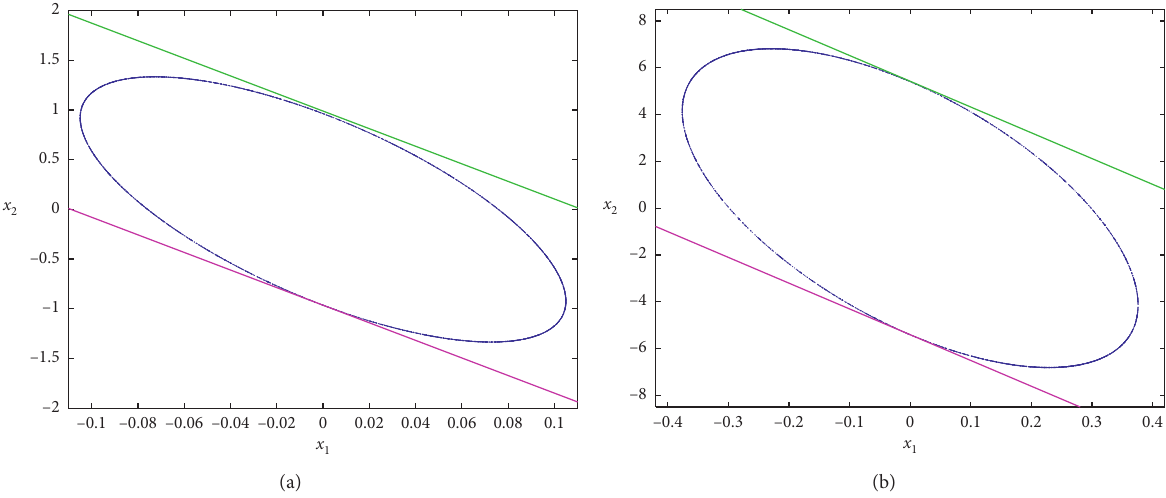
Figure 4: Largest attractive invariant ellipsoids ε